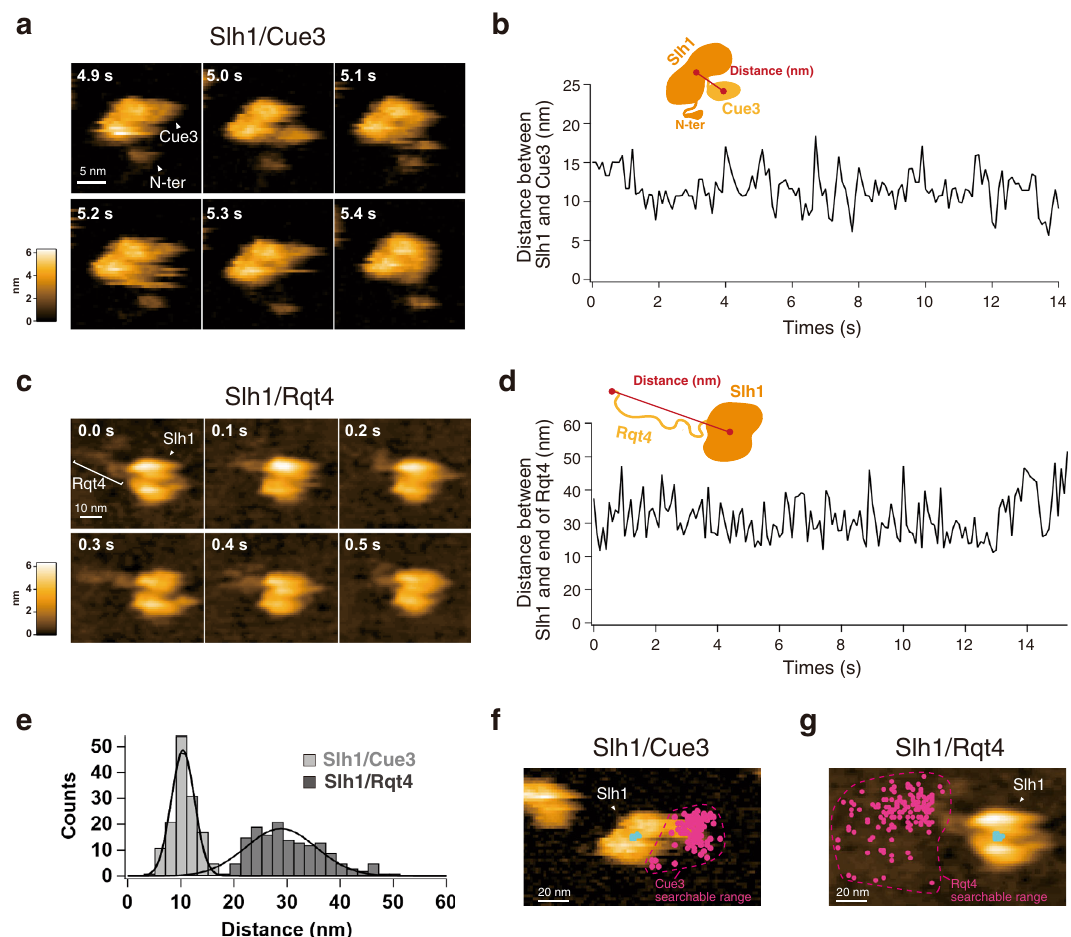
Fig. 4 | The movable range of the accessory proteins of RQT complex. a The time-lapseHS-AFMimagesoftheSlh1/Cue3complex. b Timecourseofthedistance between Slh1 and Cue3 as described in the schematic diagram. The distance was calculated for each frame per 0.1s. c The time-lapse HS-AFM images of the Slh1/ Rqt4 complex. d Time course of the distance between center of Slh1 and the most distantpointofRqt4fromcenterofSlh1asdescribedintheschematicdiagram.The distance was calculated for each frame per 0.1s. e The histogram of the Slh1-Cue3